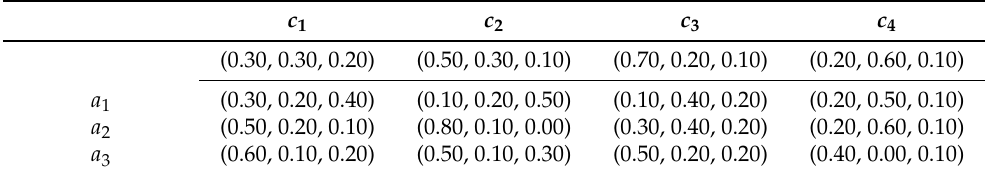
Table 3. A information system of